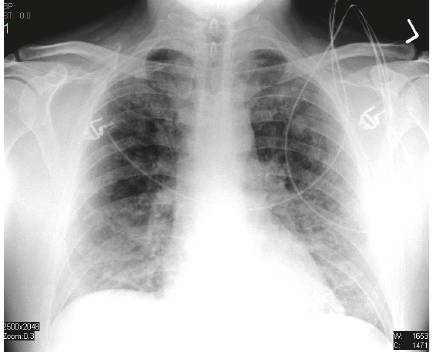
Figure 1: Initial chest X-ray.